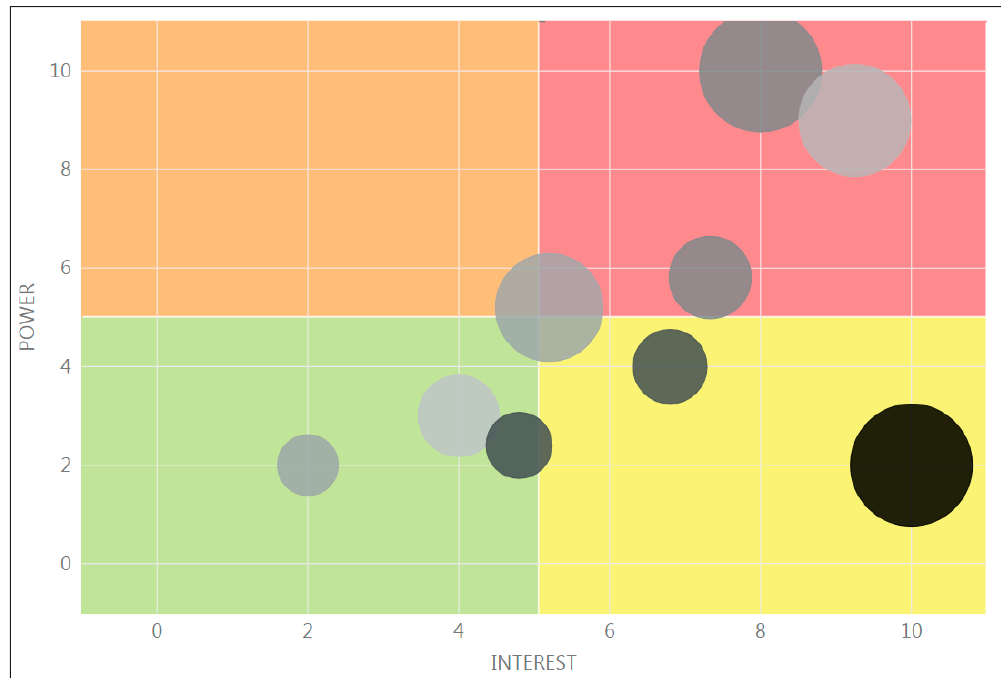
Figure 6. Example of the use of the new matrix, which shows the position of the stakeholder categories in the interest-impact matrix, the impact of some stakeholders with respect to others in the project phase and the instability of the position of each one of them.